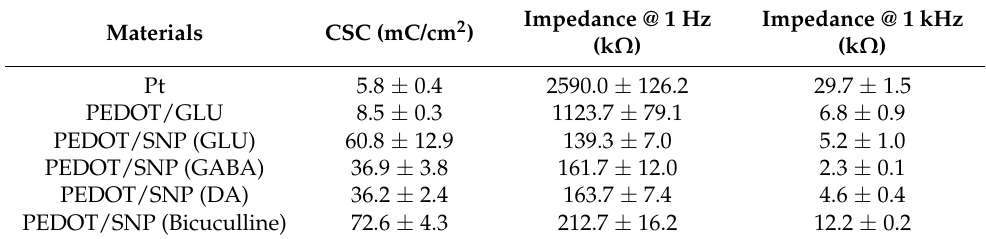
Table 1. CSC and impedance of all drugs loaded conducting polymer